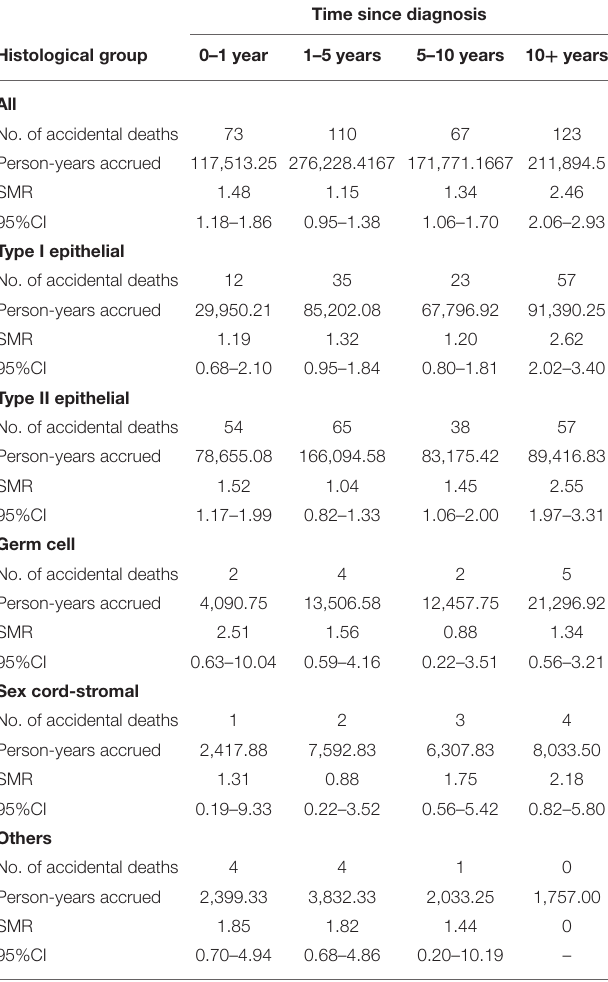
TABLE 6 | The risk of accidental death among patients with ovarian cancer by histological group and time since diagnosis. Time since